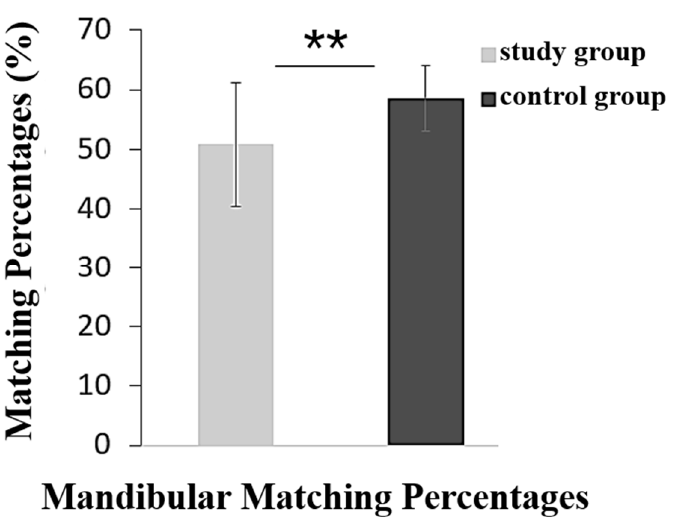
Figure 7. Mandibular matching percentages of the study group and control group. p values were based on the independent t-test. The level of significance was set at 0.05; ** = p < 0.01. The 3D distance colored maps were observed in detail. The deviation analysis of the two mandible models was displayed on a picture with a spectrum of several colors. Each color represented a different distance range from the mirrored mandible to the original mandible surface. If the distance value was high than the positive limit (0.5 mm), the map appeared yellow and red. If the value was lower than the negative limit ( − 0.5 mm), blue was displayed. The scissors bite side and non-scissors bite can be compared via this